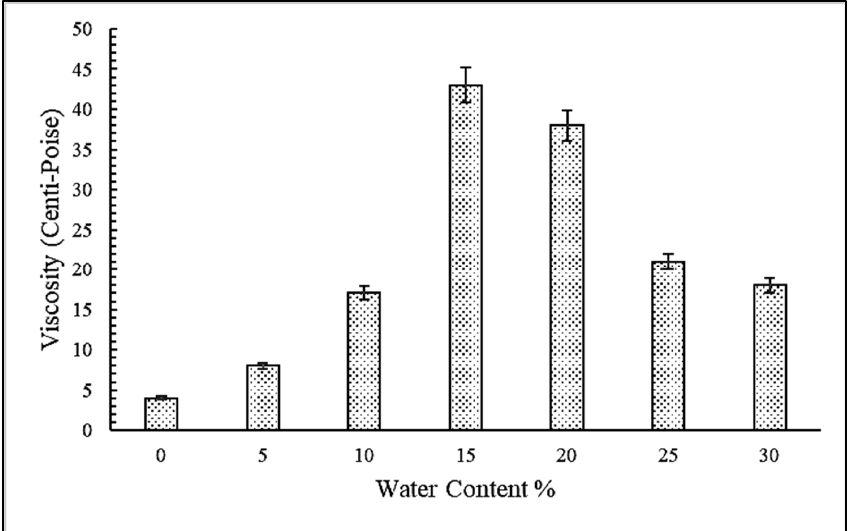
Figure 6. The viscosity of different blends of the (W/D) fuel.